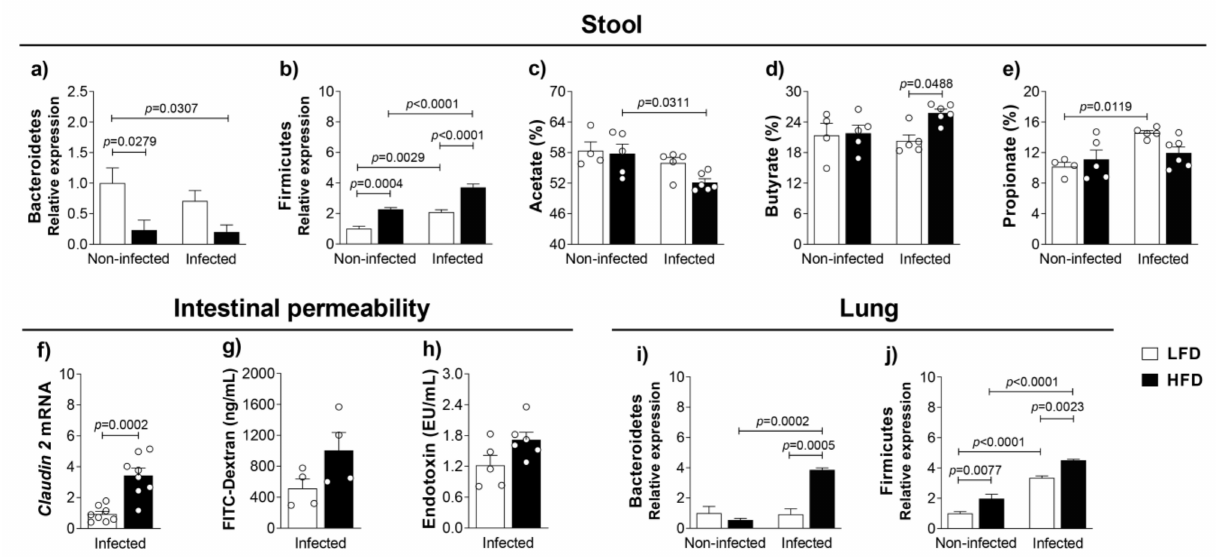
Figure 3. Obesity-induced dysbiosis in the lung and gut. C57BL/6 mice were fed with the LFD or HFD for 8 weeks and infected with M. tuberculosis by intra-tracheal (it) route. At 4 weeks post-infection (12 weeks of feeding), mice were evaluated. ( a ) Bacteroidetes and ( b ) Firmicutes relative expression from feces. Short-chain fatty acids, ( c ) acetate, ( d ) butyrate and ( e ) propionate were evaluated in stool samples ( n = 5–6). Intestinal permeability evaluated by ( f ) relative expression of claudin-2 mRNA in the ileum, ( g ) FITC-Dextran (ng/mL) and ( h ) endotoxin (EU/mL) in serum. Data are representative of two independent experiments for claudin-2 and one experiment for FITC-Dextran and endotoxin ( n = 4–8/group). ( i ) Bacteroidetes and ( j ) Firmicutes relative expression from lung samples ( n = 7–12). Data are representative of three independent experiments for Bacteroidetes analysis and two independent experiments for Firmicutes analysis. Data are representative of two independent experiments and are expressed as means ± SD. Bars show the significant difference between groups ( p <